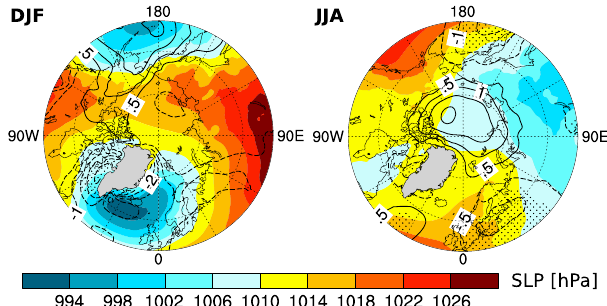
Figure 6. DJF and JJA SLP (hPa) in EEMpd and EEMr3. Shading denotes absolute SLP in EEMpd, contour lines the EEMr3–EEMpd SLP, and stippling where these anomalies are significant at the 5% level based on t test statistics. The contour interval is 0.5hPa, nega- tive values are dashed, and the zero line is not shown. Note also that SLP values are omitted over Greenland to avoid artifacts emerging from the implemented changes in the GrIS